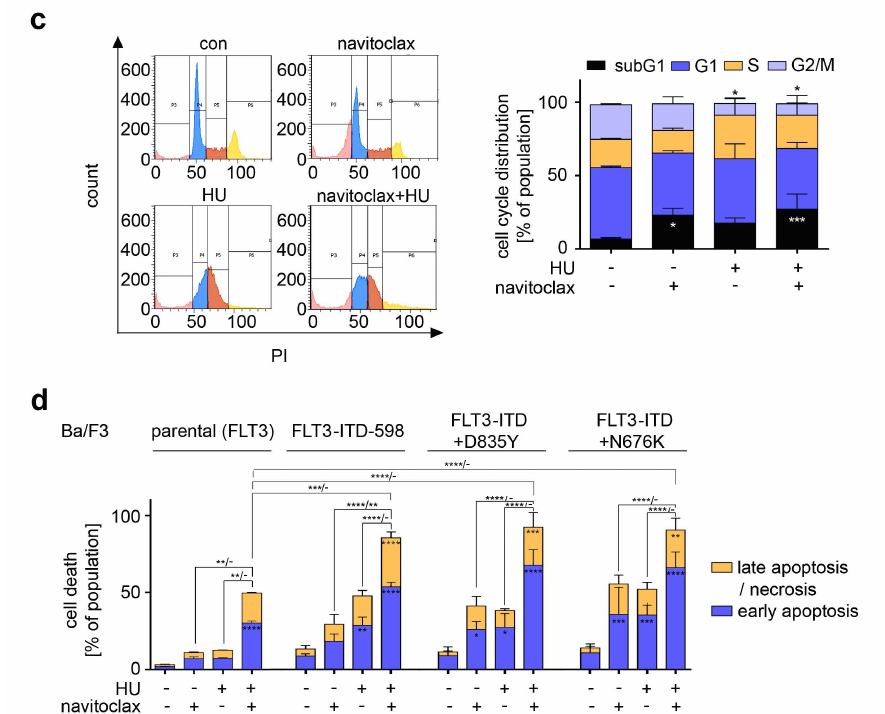
Figure 7. Inhibition of BCL-XL promotes apoptosis upon replication stress in FLT3-ITD positive cells. ( a ) Immunoblot of MV4-11 cells treated with 0.5 µ M navitoclax and 0.5 mM hydroxyurea (HU) for 24 h shows protein levels of WT1, BCL-XL, cleaved caspase-3 (casp3 (cf), caspase 3—cleaved form), and γ H2AX; HSP90 serves as loading control. Numbers below γ H2AX show densiometric analyzes of the protein expression normalized to the loading control; protein level of untreated cells was defined as 1.0. ( b ) Upper left: Exemplary dot plots of MV4-11 cells treated with 0.5 µ M navitoclax and 0.5 mM HU for 24 h. Cells were stained with annexin-V-FITC and PI and analyzed by flow cytometry. Upper right: Cell death calculations of annexin and PI stained MV4-11 cells treated as mentioned before; n = 3 ± SD; two-way ANOVA; Bonferroni’s multiple comparisons test: ** p < 0.01; **** p < 0.0001. Lower left: Representative overlay histogram of samples treated with 0.5 µ M navitoclax and 0.5 mM HU for 24 h. Cells were stained with DiOC6 to measure ∆Ψ m. Decreased Ψ m is a sign of ongoing apoptosis. Lower right: DiOC6 stained cells treated as indicated were analyzed for ∆Ψ m; n = 3 ± SD; one-way ANOVA; Bonferroni’s multiple comparisons test: * p < 0.05; ** p < 0.01. ( c ) Cells were treated with 0.5 µ M navitoclax and 0.5 mM HU for 24 h, fixed and stained with PI. Left: Cell cycle distributions were analyzed by flow cytometry. Shown are representative histograms. Right: Cell cycle distributions of such cells; n = 3 ± SD; two-way ANOVA; Bonferroni’s multiple comparisons test: * p < 0.05; *** p < 0.001. ( d ) Ba/F3 cells were treated with 0.5 µ M navitoclax and 0.5 mM HU for 24. Cells were stained with annexin-V-FITC and PI and analyzed by flow cytometry; n = 3–4 ± SD; two-way ANOVA;